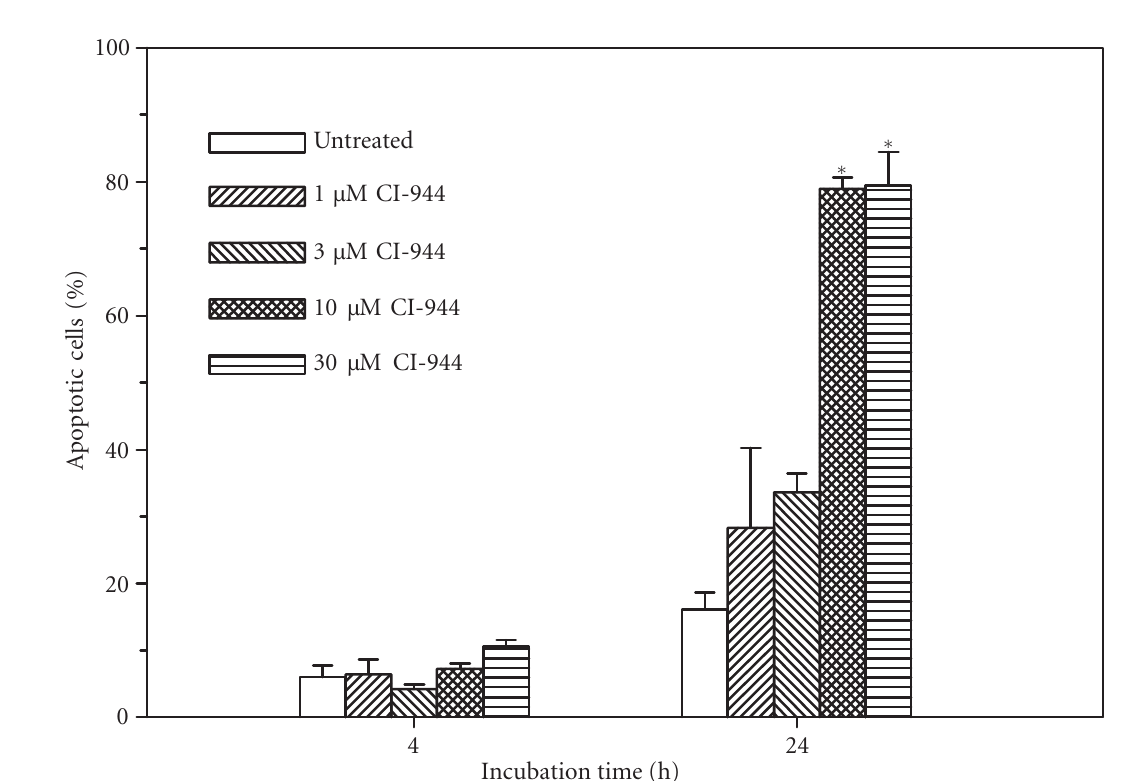
Figure 2: Apoptosis in rat peripheral blood lymphocytes exposed to CI-994 for 4 or 24hours. Mitogen (concanavalin A, 0.63 µ g/ml) was added to all lymphocyte cultures at time zero. Apoptotic cells characterized by condensed DNA were visualized by fluorescent microscopy and acridine orange/ethidium bromide stain. Data represent the mean ± SE of at least 4 individual experiments. ∗ Significantly different from control using Kruskal-Wallis one way ANOVA on ranked data and Dunn’s post hoc test ( p < 0 . 05 ).